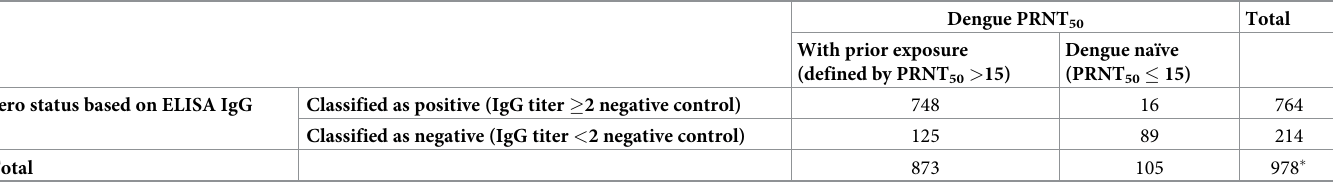
With prior exposure (defined by PRNT 50 >